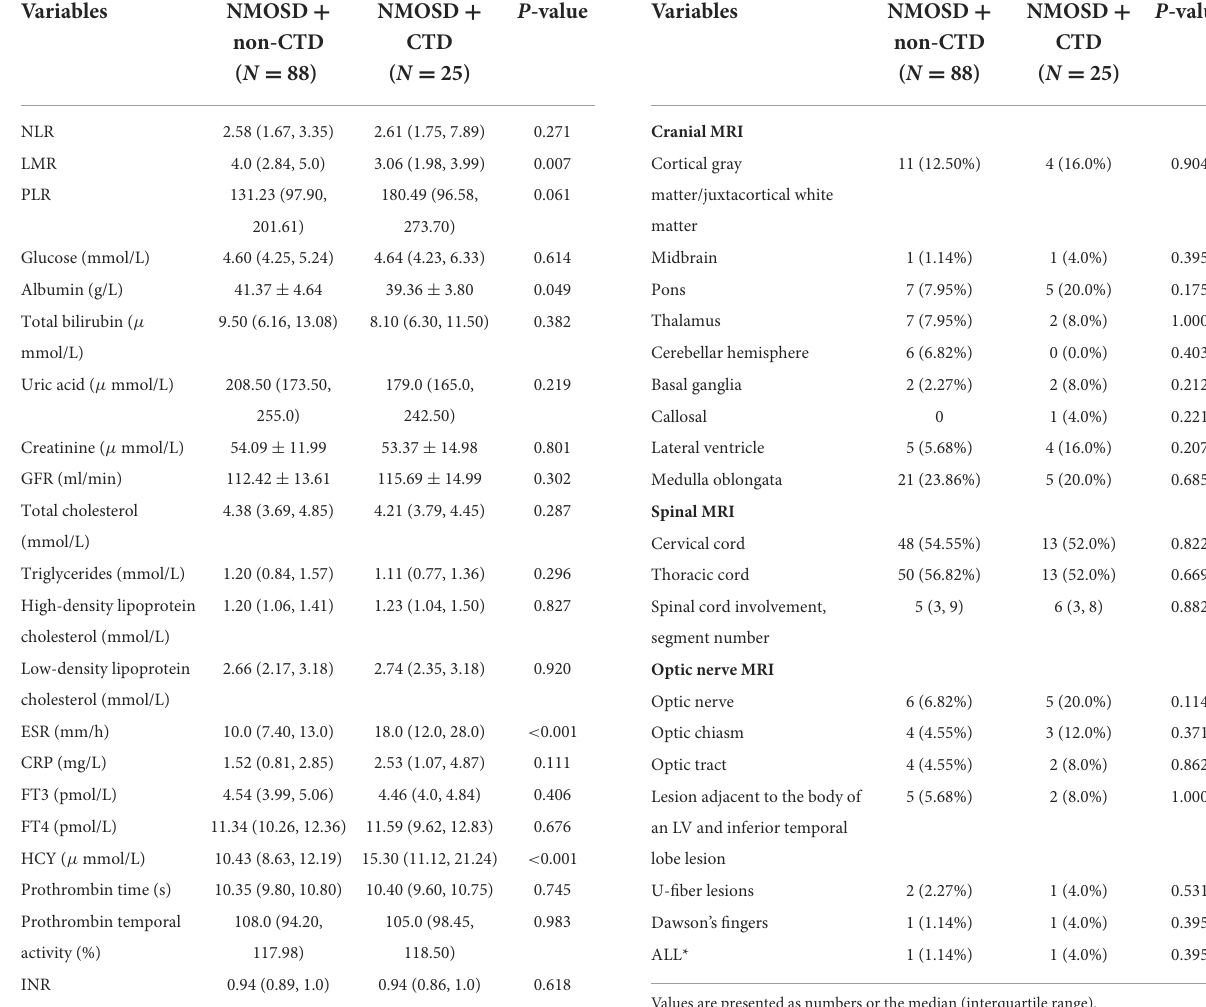
TABLE 4 Blood tests results in patients of first-attack NMOSD with and without CTD.